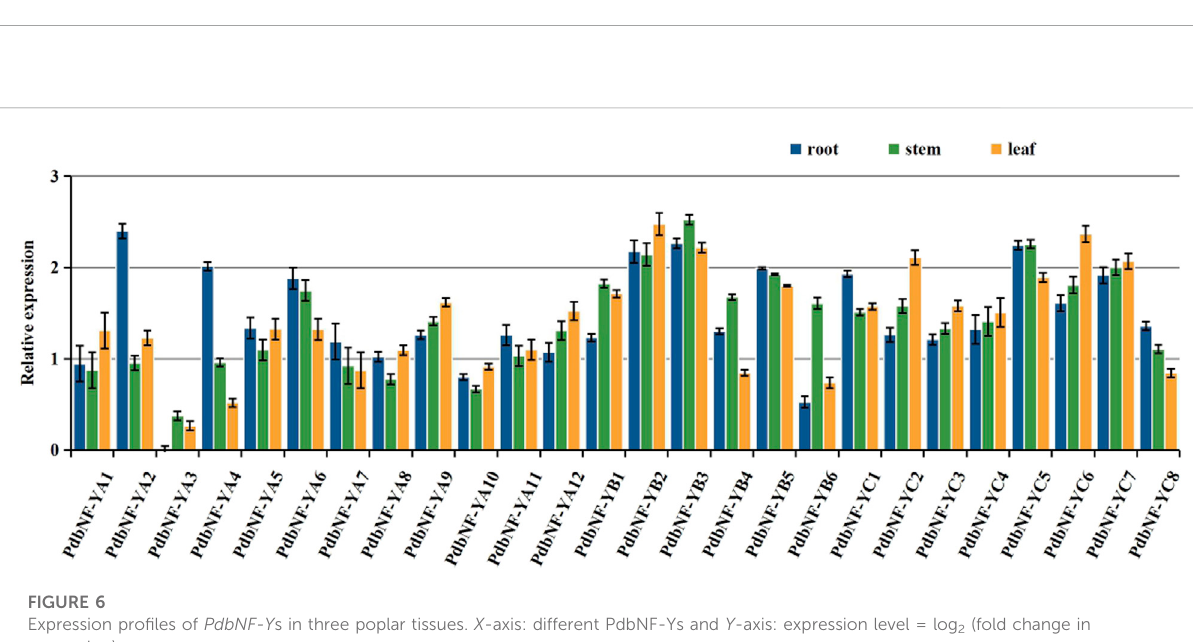
FIGURE 6 Expression pro fi les of PdbNF-Y s in three poplar tissues. X -axis: different PdbNF-Ys and Y -axis: expression level = log 2 (fold change in expression).